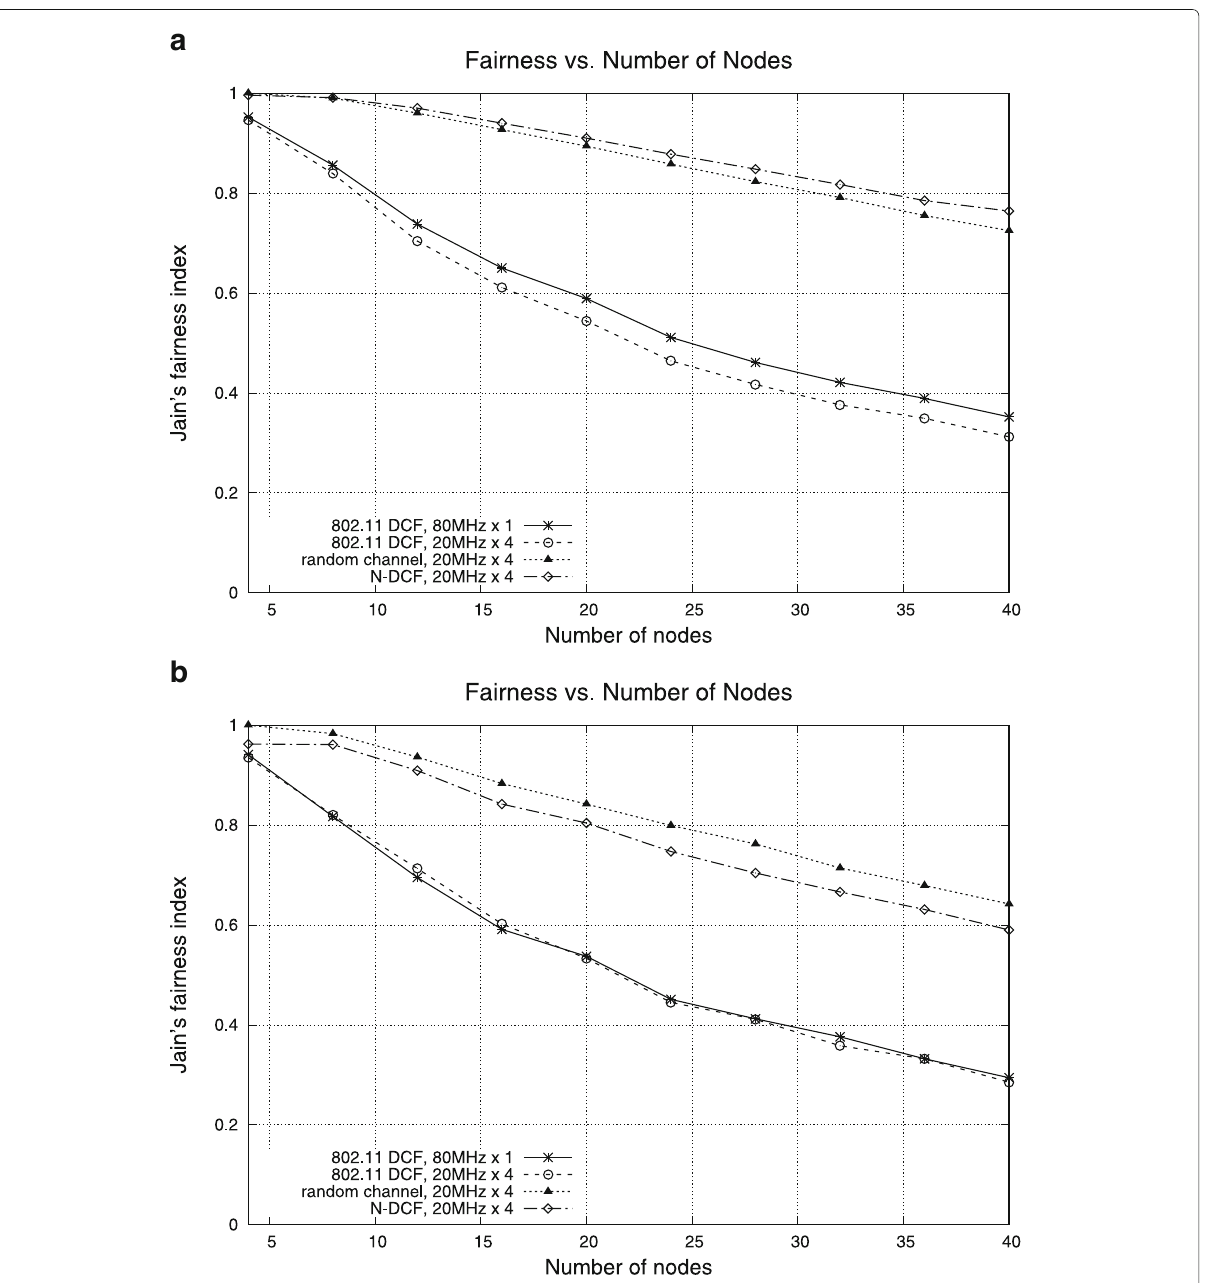
Fig. 11 Jain’s fairness index varying number of nodes. a A-MPDU size = 3000 bytes. b A-MPDU size = 65,535